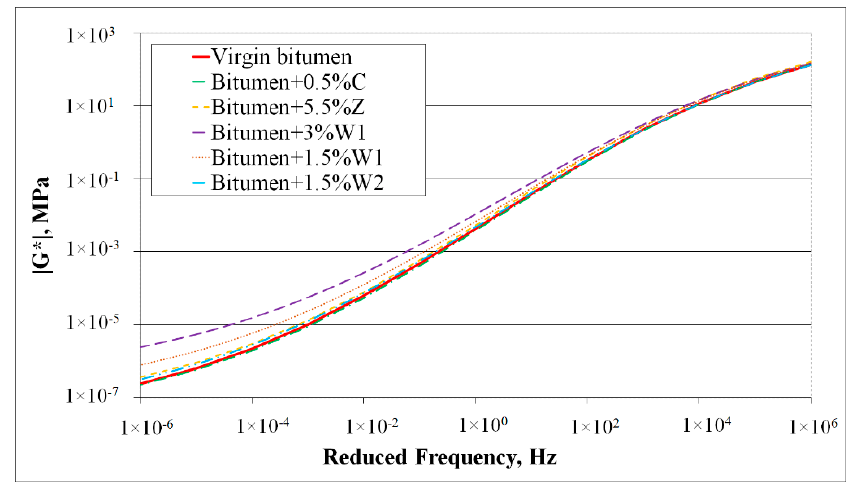
Figure 3. DSR master curves for complex modulus |G*| of 50/70 virgin bitumen and bitumen blends containing additives.